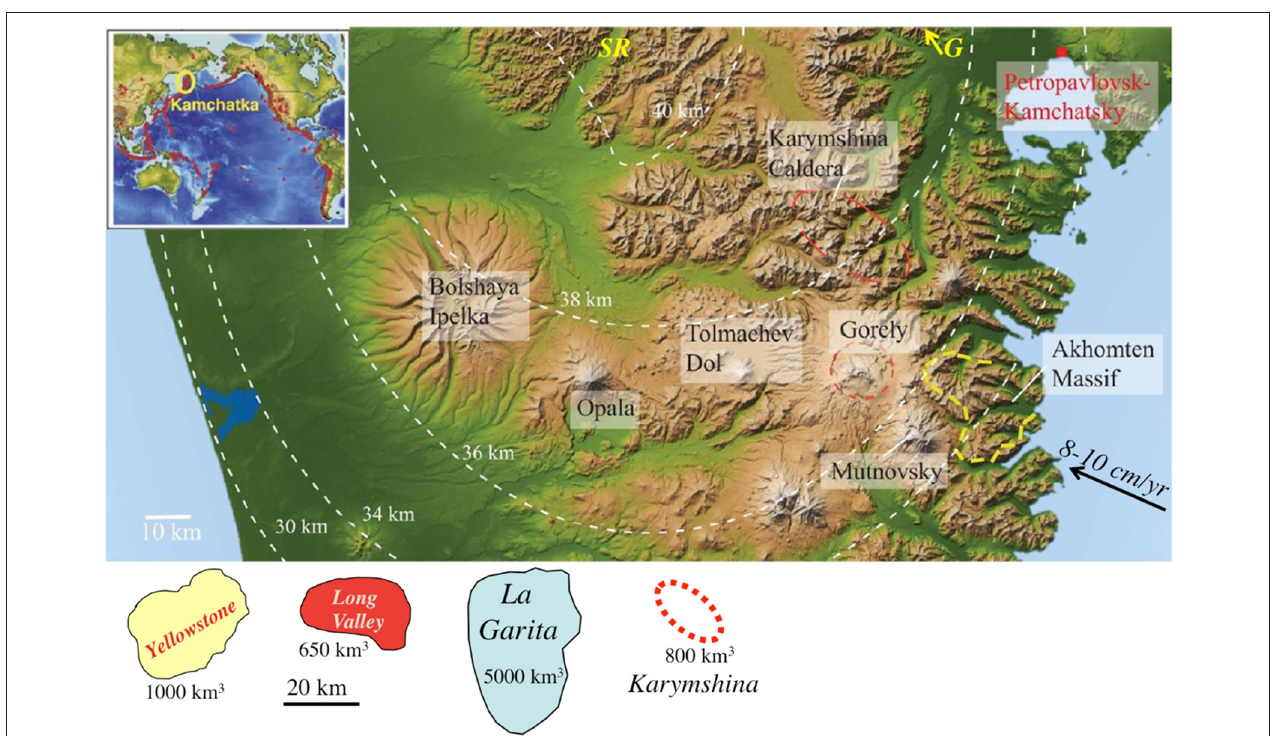
FIGURE 1 | Karymshina Volcanic Complex in Kamchatka. Inset: plate tectonic configuration, and presently active volcanoes of the Eastern Volcanic Front, and extinct volcanic arc in the Sredinny Range. A cross section through south-central Kamchatka shows Karymshina Volcanic Complex and other neighboring volcanoes mentioned in text. Notice uplift and topographic manifestation of Late Pleistocene calderas (e.g., Gorely), ignimbrite sheets around it and glacial coastal fjords and erosional features. Crustal thickness is shown my dashed line from Baboshina et al. (2000). Ganal metamorphic basement (G) with mafic amphibolites of Cretaceous age is to the NW of the letter G, while Sredinny Range with siliceous gneisses extends north of the letter SR. Lower panel shows comparison of caldera outlines mentioned in text and their eruptive